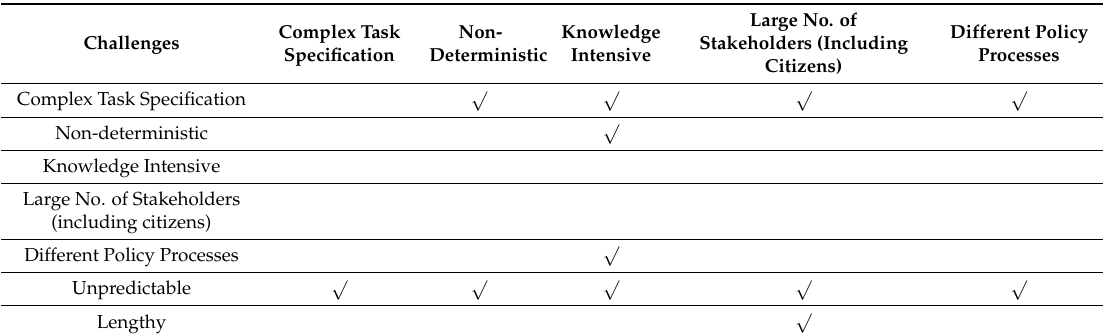
Table 1. Challenges